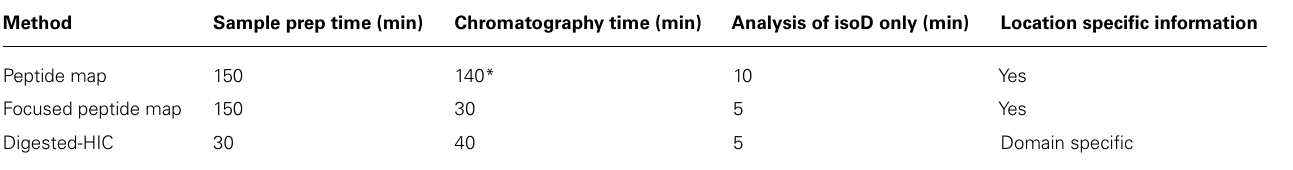
Table 1 | Evaluation of isoAsp detection